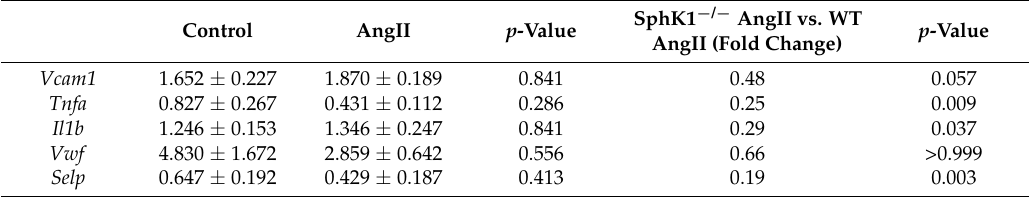
Table 1. Chemokine and cytokine transcript levels in brain tissue of SphK1 − / − mice. qPCR-based assessment of pro-inflammatory chemokines and cytokines and endothelial activation markers in brain tissue of SphK1 − / − mice after chronic AngII or saline perfusion. Comparisons to hypertensive WT mice (WT AngII) are indicated as fold changes. Data expressed as mean ± SEM; n = 6; p values calculated for single unpaired comparisons. SphK1 − / − AngII vs.